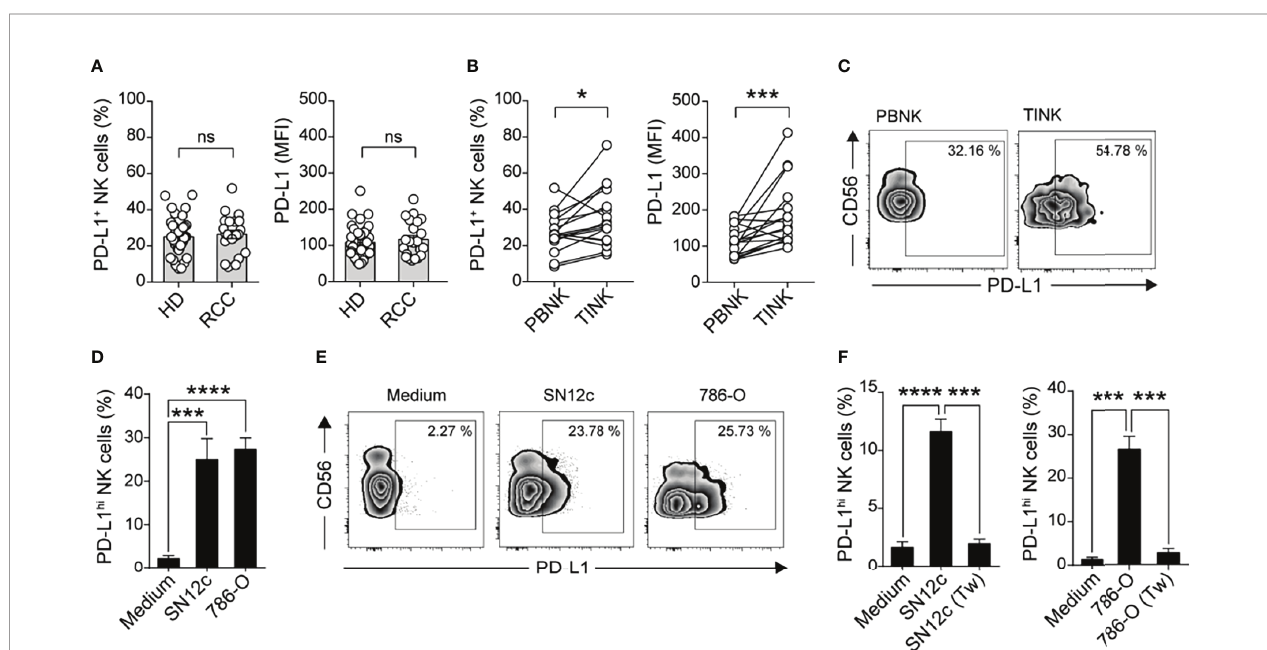
FIGURE 2 | TINK cells from patients with ccRCC exhibit an accumulation of PD-L1 + cells and increased expression of PD-L1. (A) Frequency of PD-L1 + NK cells (left) and expression of PD-L1 (right) on PBNK from healthy donors (HD, n=41) and ccRCC patients (n=22), assessed by fl ow cytometry. (B) Frequency of PD-L1 + NK cells (left) and MFI of PD-L1 (right) on PBNK and TINK from matched ccRCC patients, assessed by fl ow cytometry (n=17). (C) Representative zebra plots of CD56 vs PD-L1 on PBNK and TINK from a representative ccRCC patient. (D) Frequency of PD-L1 hi NK cells after culture of PBMC from HD in the absence (Medium) or in the presence of SN12c or 786-O RCC cell lines for 48 h, assessed by fl ow cytometry (n=12). (E) Representative zebra plots. (F) Frequency of PD-L1 hi NK cells after culture of PBMC from HD in the absence (Medium) or in the presence of SN12c or 786-O RCC cell lines in contact or separated by transwells (Tw) for 48 h, assessed by fl ow cytometry (n=7). Two-sided Student´s t test (A, B) ; one-way ANOVA with Dunnett´s post hoc test (D, F) . Data represent mean ± SEM (D, F) . ns, non-signi fi cant; * p <0.05, *** p <0.001, **** p